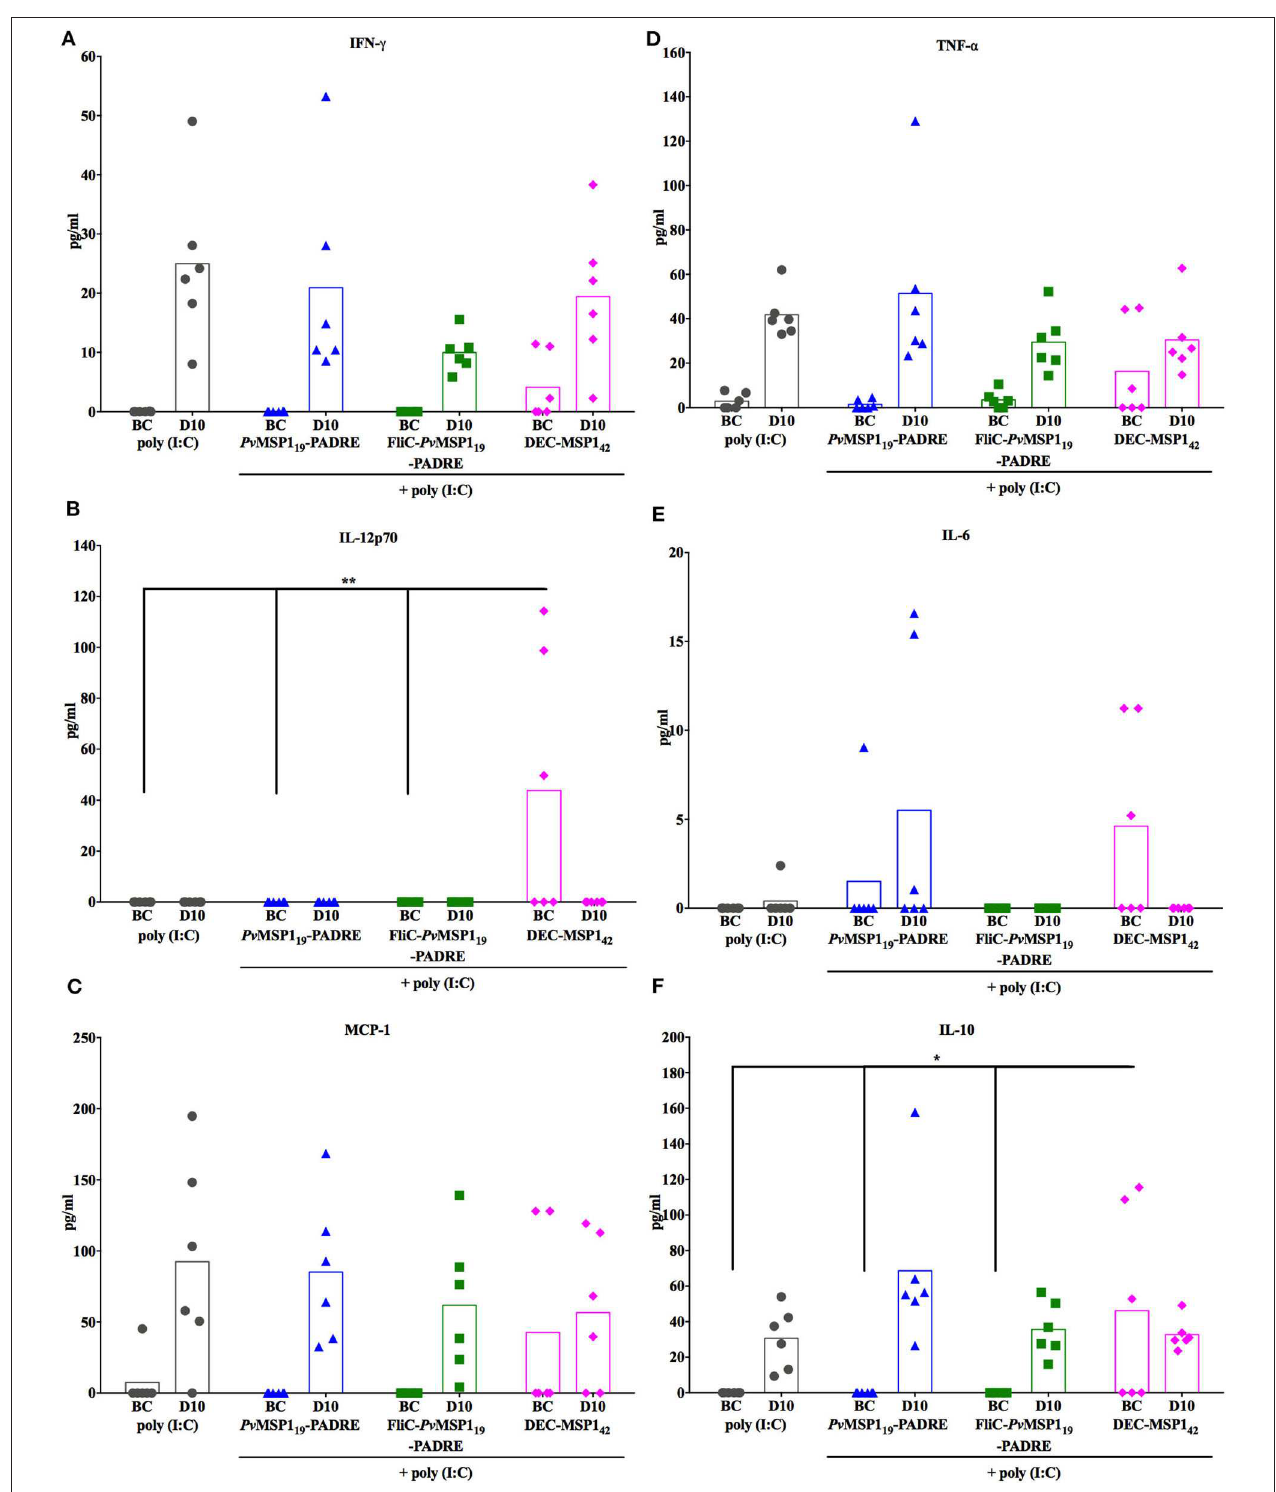
FIGURE 8 | Cytokine responses in vaccinated mice before challenge and at day 10 post-challenge. The amounts of IFN- γ (A) , IL-12p70 (B) , MCP-1 (C) , TNF- α (D) , IL-6 (E) , and IL-10 (F) were measured by CBA in the sera of mice from the indicated groups ( n = 6) before challenge (BC) and at day 10 (D10) post-challenge. One-way ANOVA followed by Tukey’s HSD test: ns, non-significant; * p < 0.05 and ** p < 0.01.